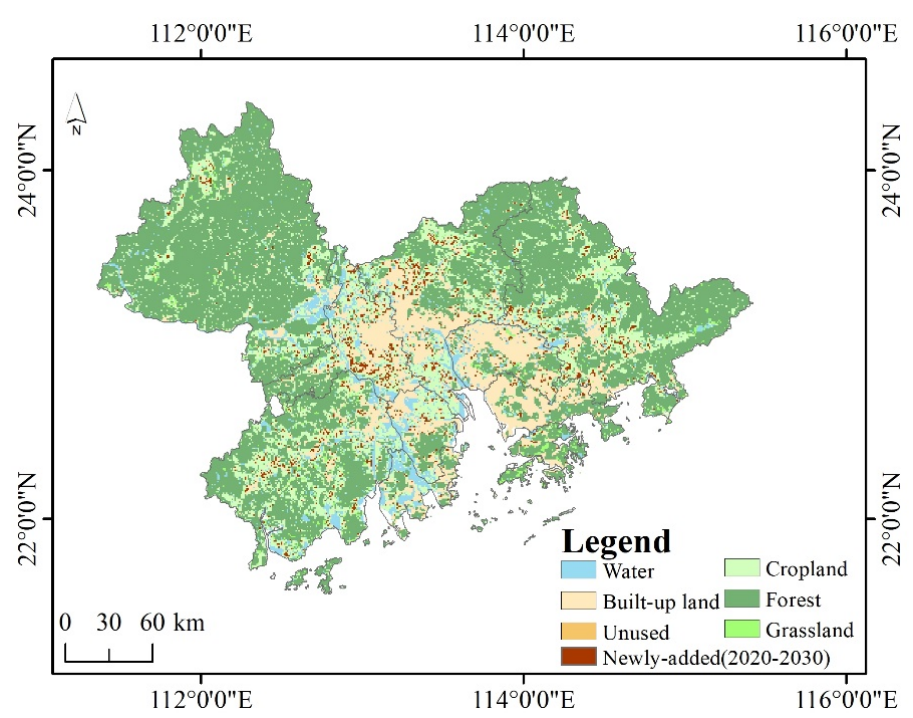
Figure 11. The spatial distribution of newly added built-up land in 2030.